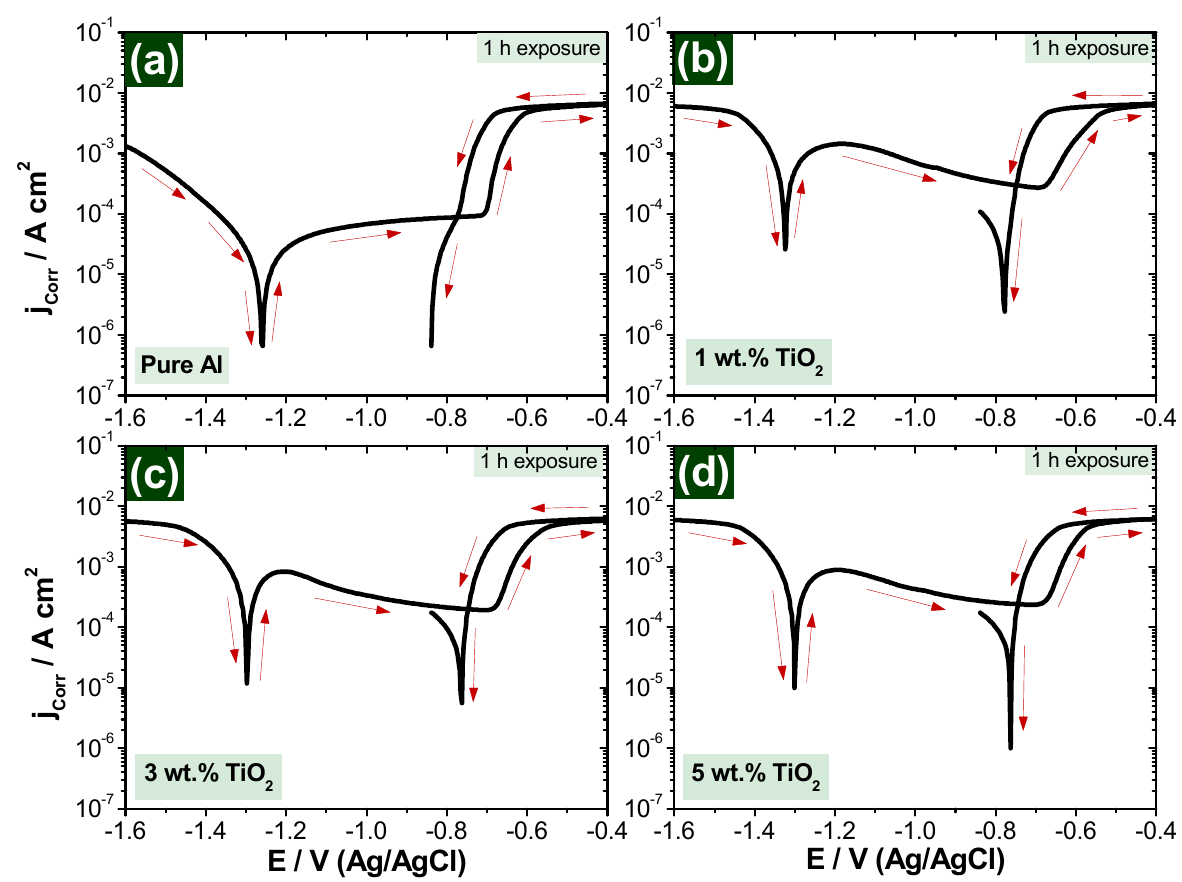
Figure 9. CPP for composite samples exposed for 1-h in 3.5% NaCl solution ( a ) Pure Al, ( b ) 1 wt.% TiO 2 , ( c ) 3 wt.% TiO 2 and ( d ) 5 wt.% TiO 2 .